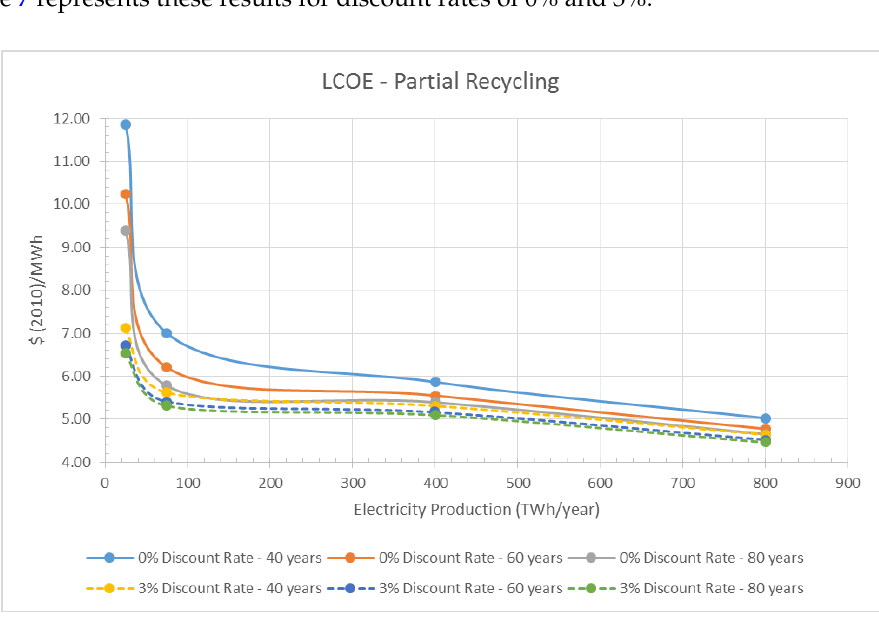
Figure 7. LCOE for partial recycling.